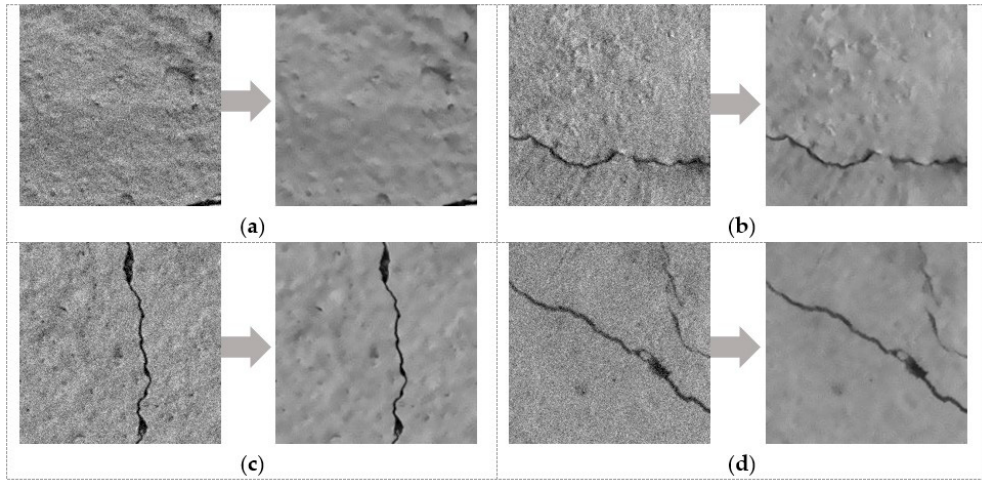
Figure 3. Image processing results using non-local means method: ( a ) Without crack; ( b ) longitudinal crack; ( c ) transverse crack; ( d ) oblique crack.